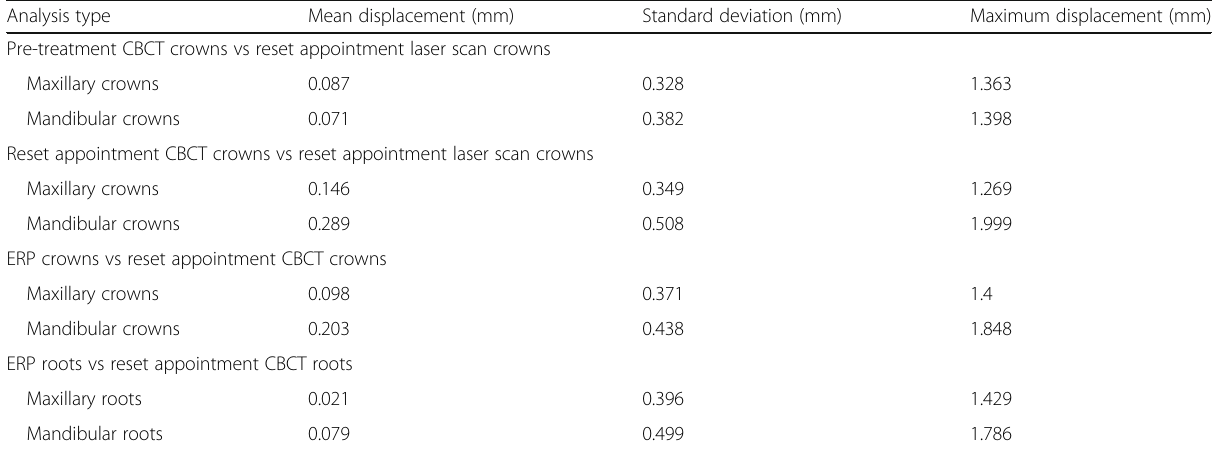
Table 1 Color displacement map